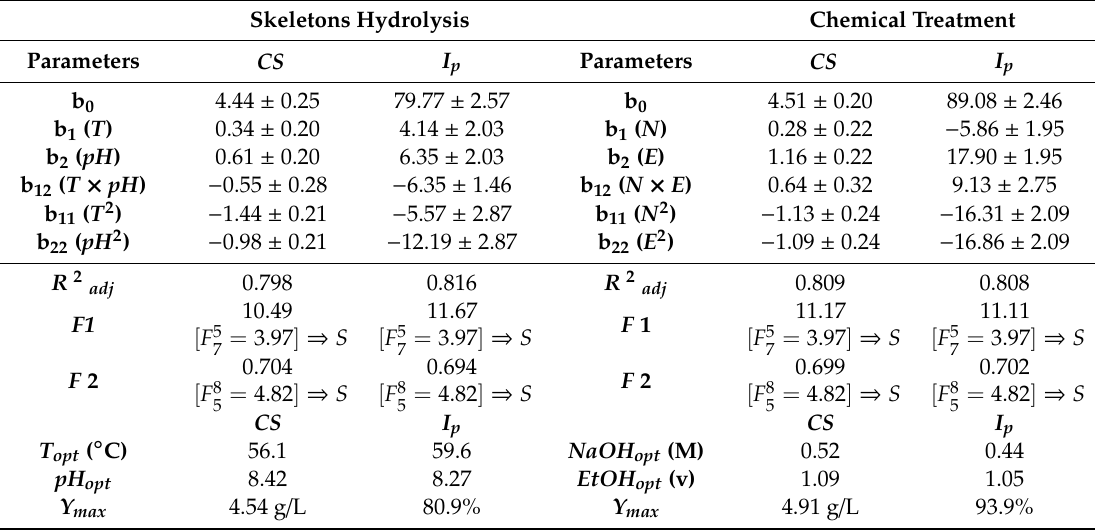
Table 2. Polynomial equations describing the e ff ect of T and pH on alcalase skeleton hydrolysis (CS isolation and I p -index) and characterising the e ff ect of NaOH ( N ) and EtOH ( E ) on the precipitation of previous hydrolysates. The coe ffi cient of determination and adjusted determination ( R 2 and R 2 adj ), F-values and optimal conditions of the independent variables are also shown. S: